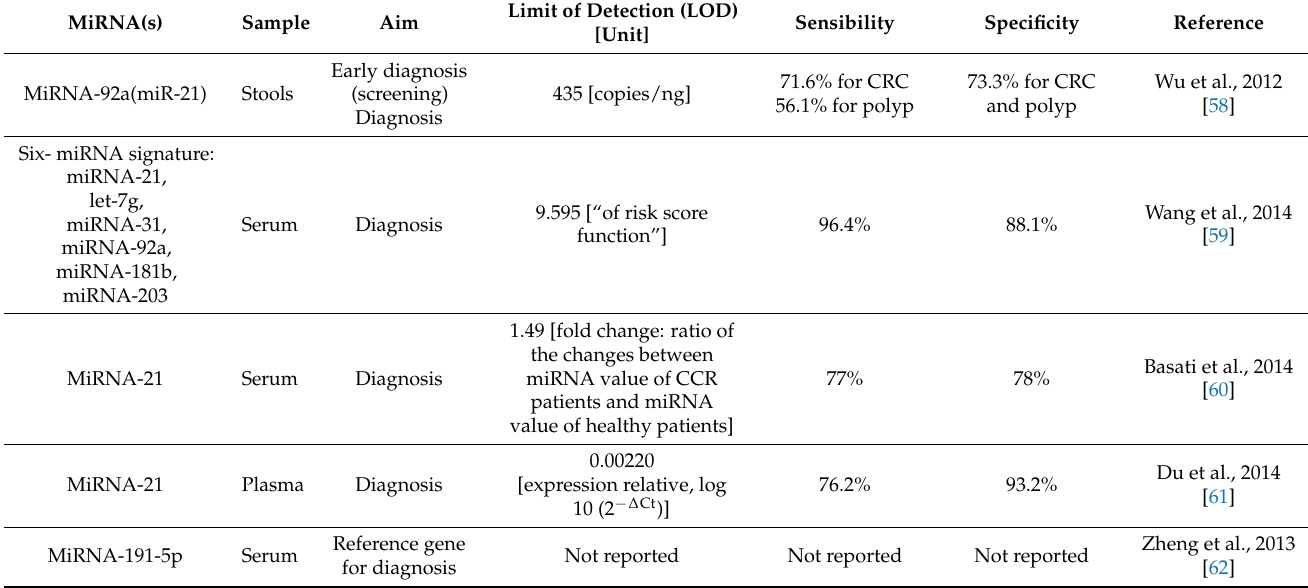
Table 2. MiRNAs as diagnostic